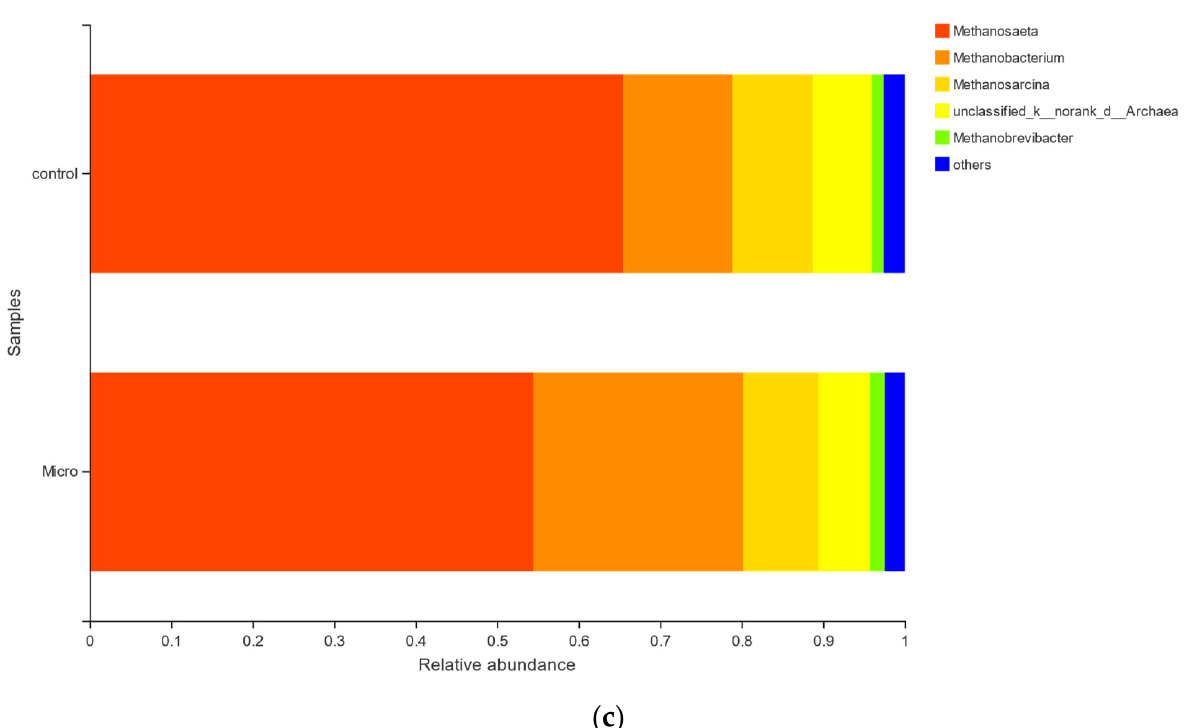
Figure 9. ( a ) Phylum-level relative abundance of archaeal communities; ( b ) class-level relative abundance of archaeal communities; ( c ) genus-level relative abundance of archaeal communities.